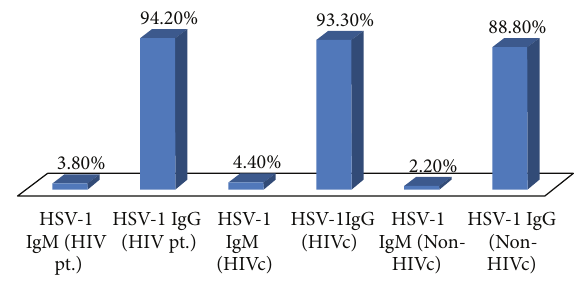
Figure 1: Prevalence of HSV-1 IgM and IgG in HIV pt., HIVc, and non-HIVc group.